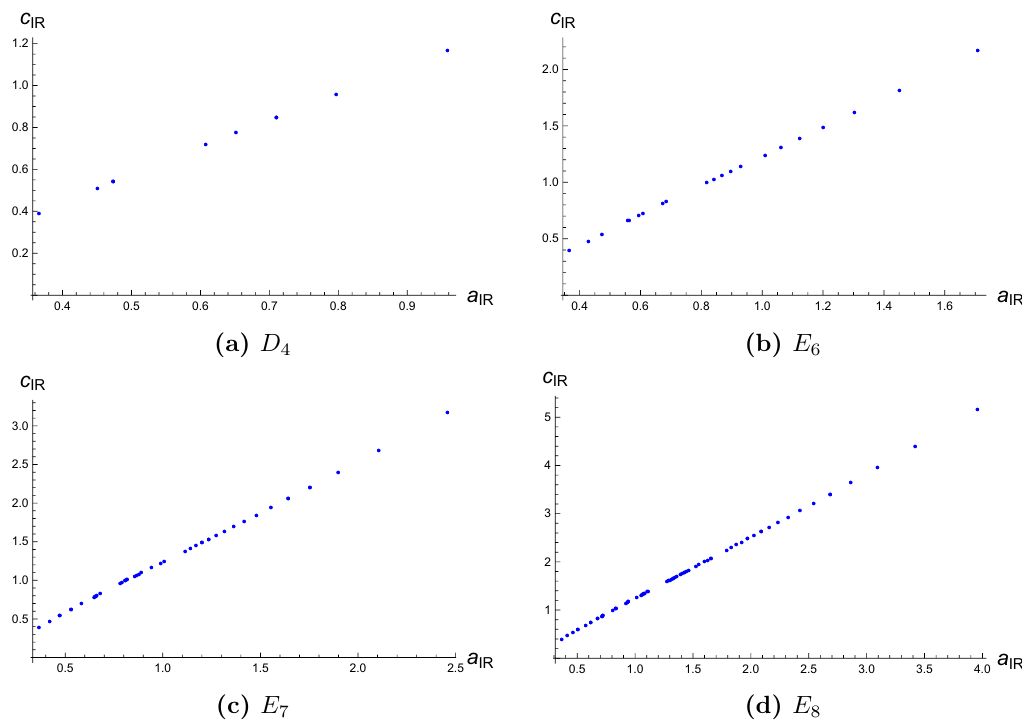
Figure 5. Plots of c IR vs. a IR for plain nilpotent mass deformations of the di(cid:11)erent probe D3-brane